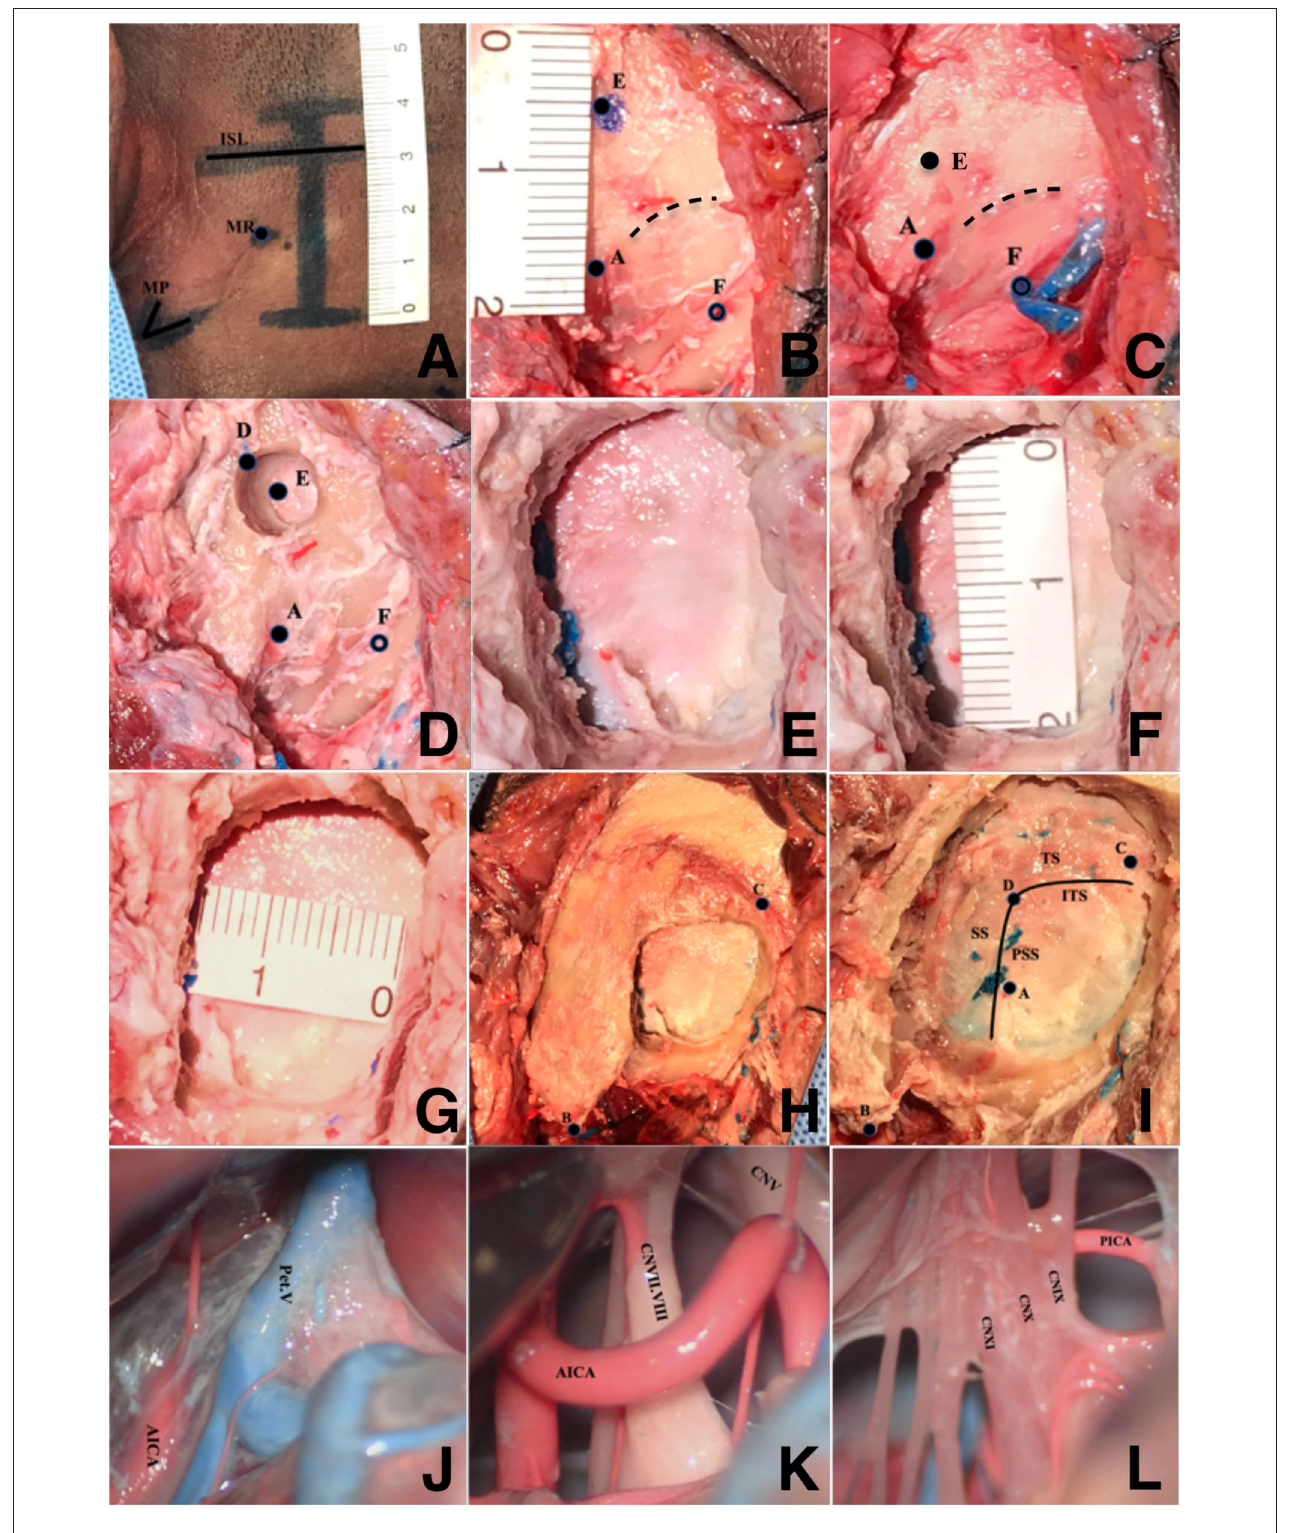
FIGURE 2 | Imitating the new craniotomic method of the retrosigmoid keyhole approach on wet cadaveric specimens. (A) Incision of the scalp, (B) recognize the bone landmarks, (C) confirm the position of the drilling point, (D) burr a hole, (E) the bone window of the operating area, (F) the supero-inferior diameter of the bone window, (G) the anteroposterior diameter of the bone window, (H) locate the position of the mastoidale and asterion, (I) observe the relationship between the